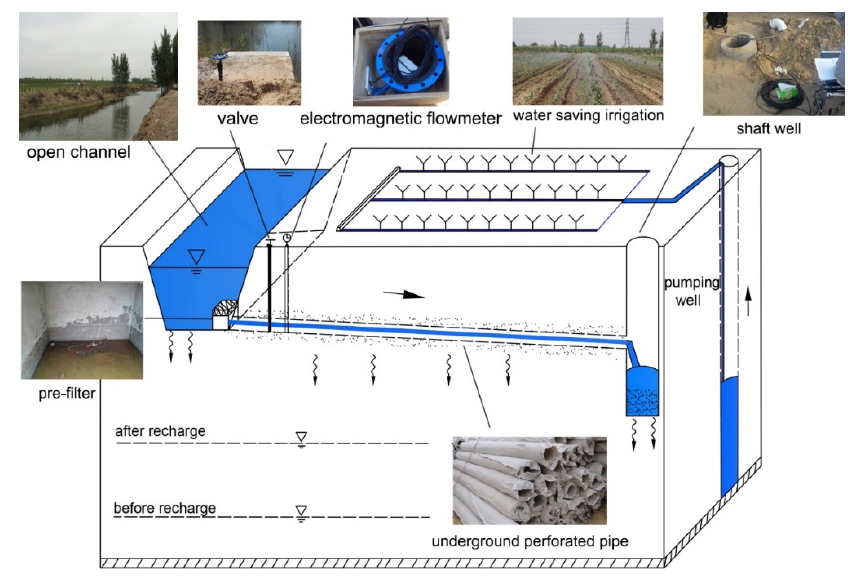
Figure 5. Open channel–underground perforated pipe–shaft–water saving irrigation system.